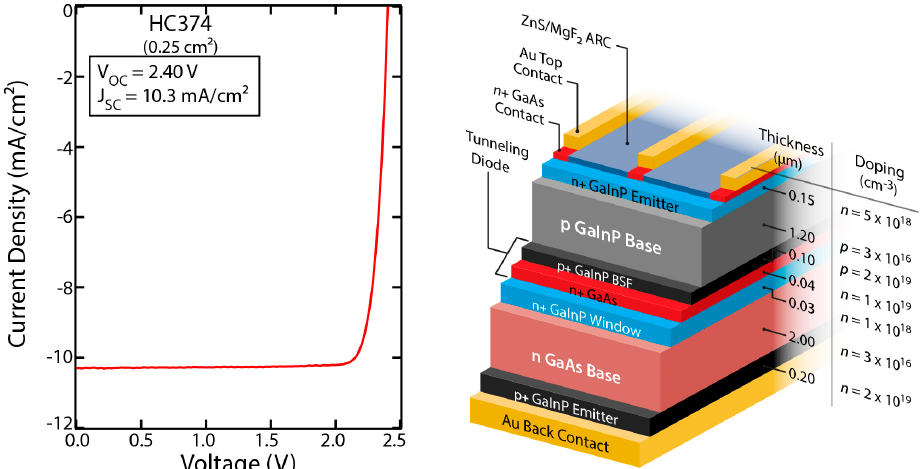
Figure 6. Current density-voltage characteristics for an HVPE-grown multijunction solar cell device under the AM1.5G solar spectrum. The structure of device is shown on the